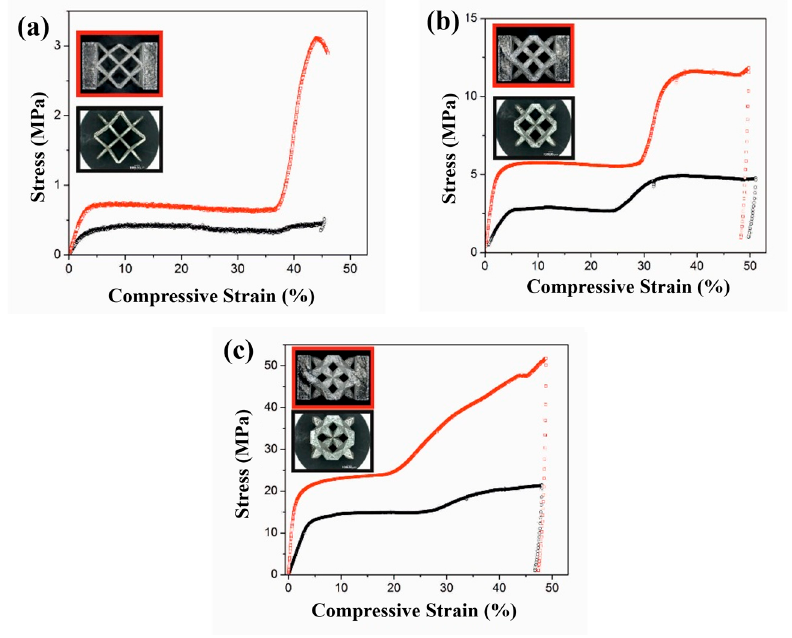
Figure 8. Compressive stress-strain diagrams of the single-unit cells (black curves) and the single-unit cells with baseplates (red curves) with different relative densities: ( a ) 4%; ( b ) 12%, and ( c ) 24%, respectively.